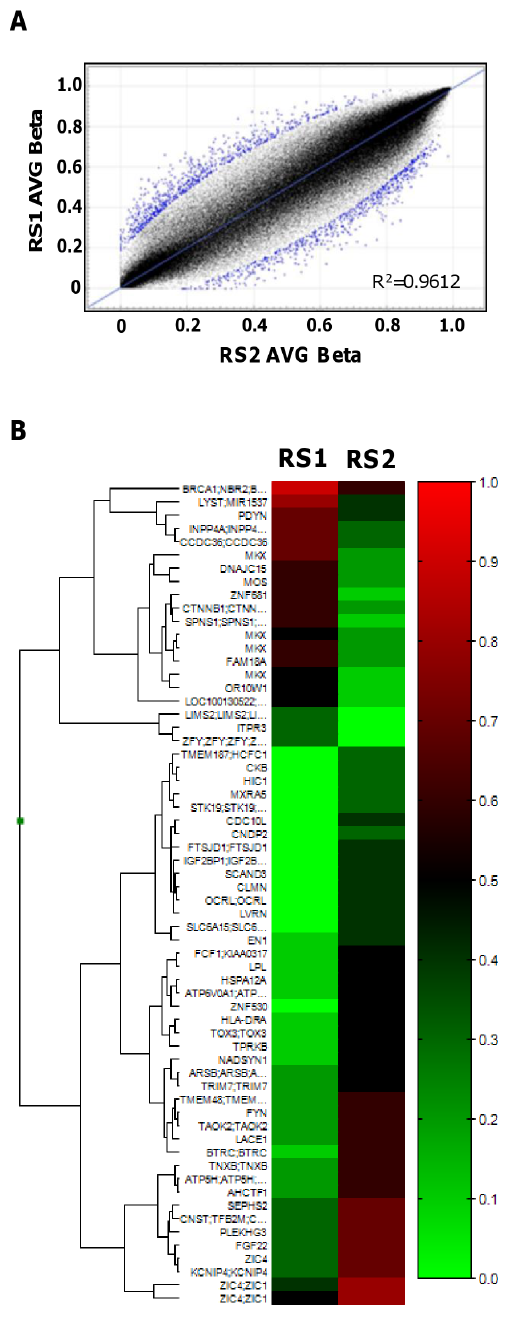
Figure 4. Results of genome-wide analysis of DNA methylation in the twins. (A) Correlation of DNA methylation at the CpG sites analyzed between the twins based on an average (AVG) beta value. (B) Differentially methylated CpG sites between the twins. Red indicates hypermethylation and green indicates hypomethylation.